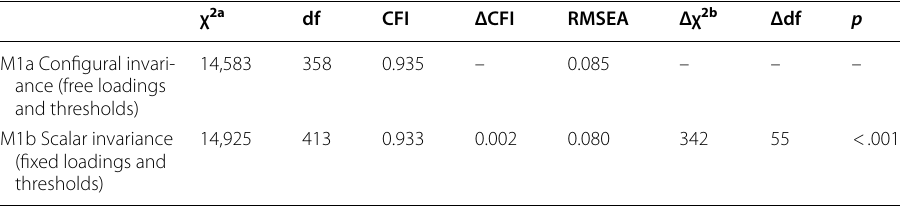
Table 7 Testing measurement invariance between Switzerland and Germany for ICT Engagement scales